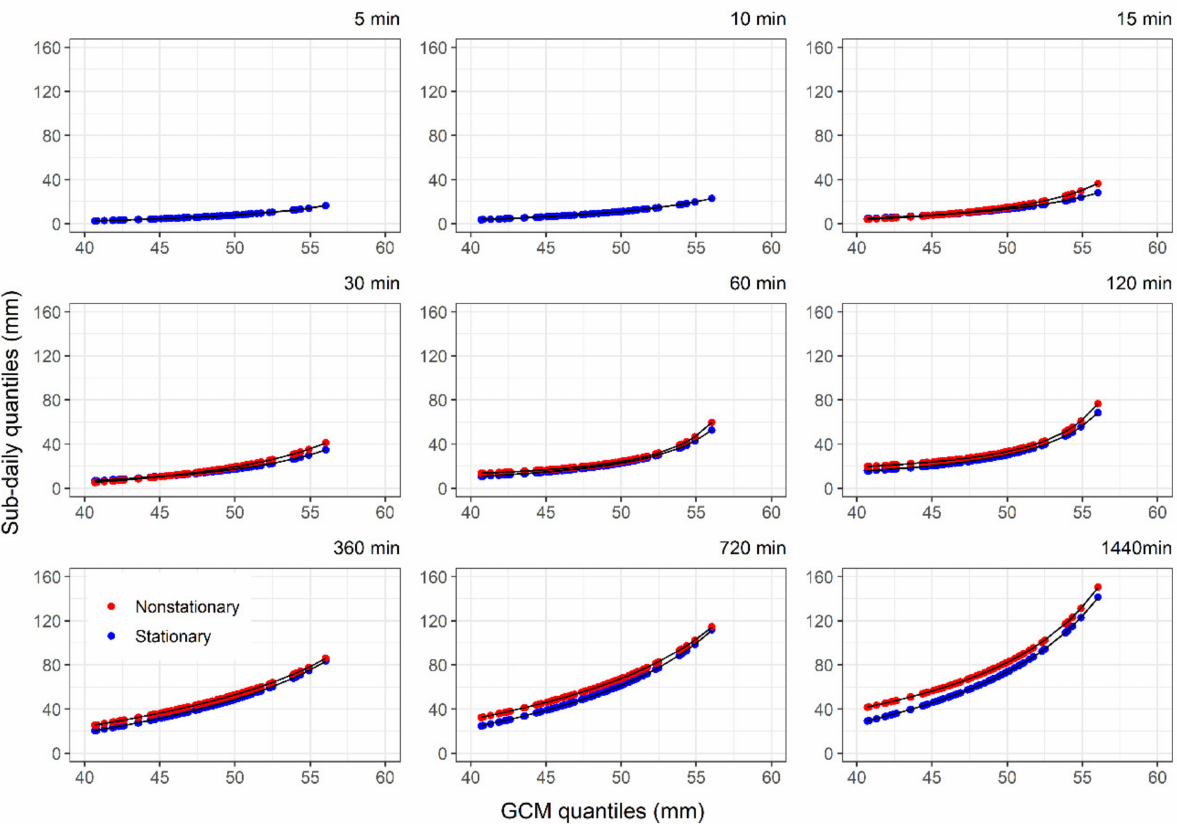
Figure 5. Quantile-mapping method for spatial downscaling for different durations. Lines represent the non-linear